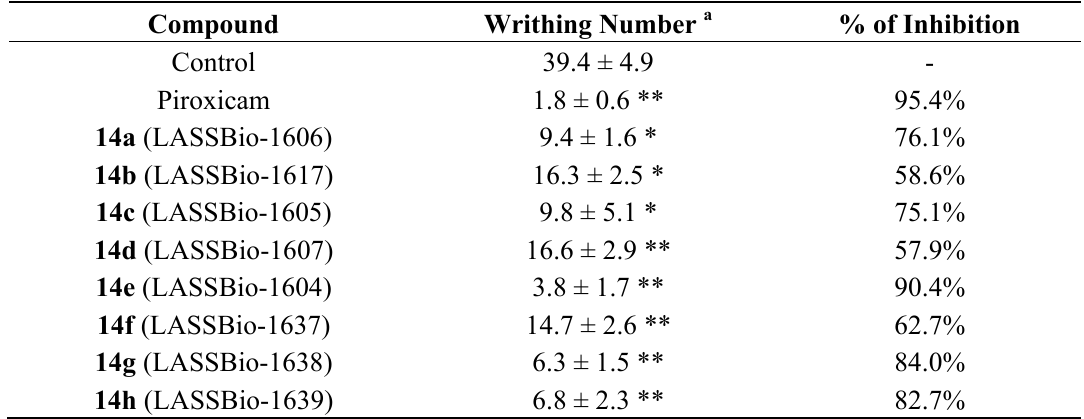
Table 1. Effect of compounds 14a – h and piroxicam (100 µmol/kg, p. o.) on acetic acid-induced writhing test in mice.